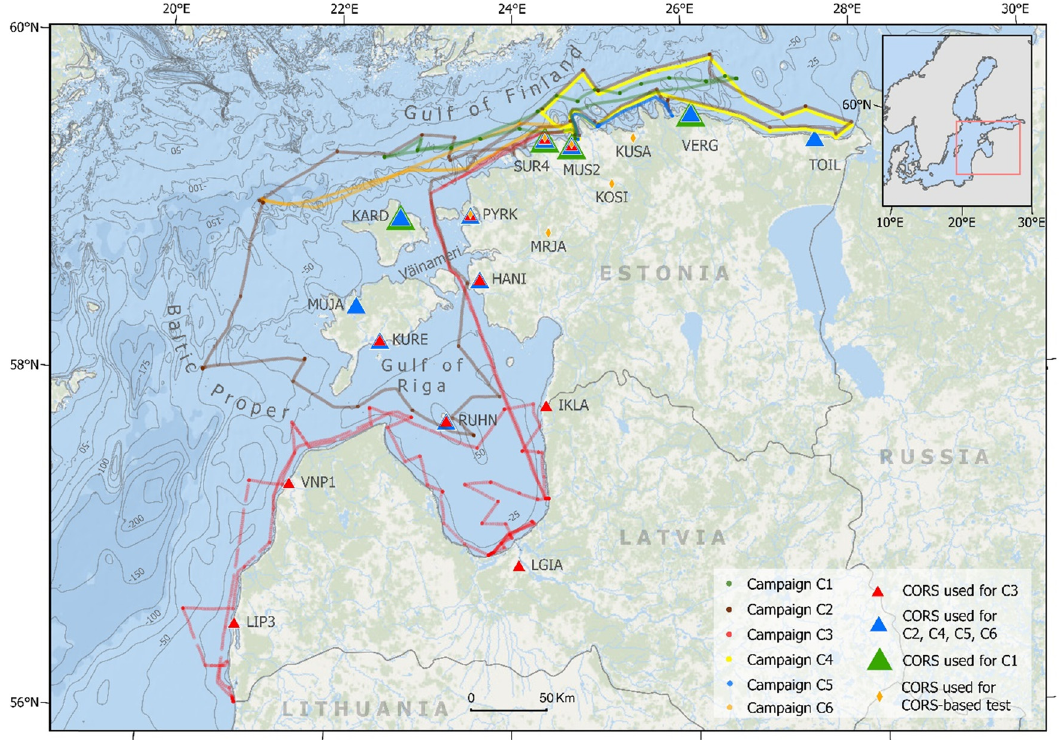
Figure 1: Six marine expeditions conducted in the Baltic Sea in spring and summer 2021, supervised by the Marine Systems Institute from the Tallinn University of Technology. Note that the dots in ship routes denote stops for conducting various marine experiments. The bathymetry data are from the Baltic Sea Bathymetry Database ( data.bshc.pro )